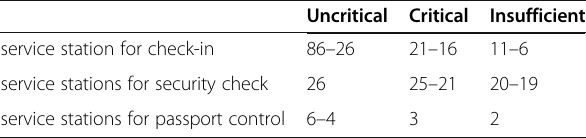
Table 3 Assessment of the number of available service stations at passenger handling processes as uncritical, critical and insufficient to maintain flight